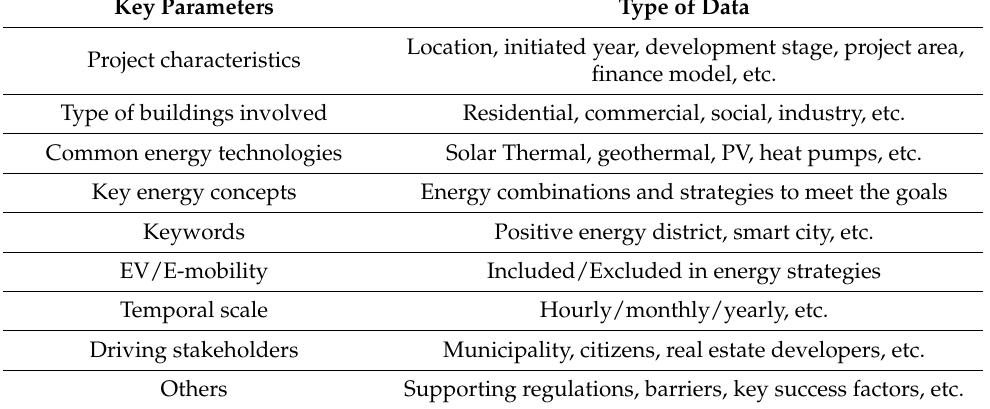
Table 1. Table parameters for data